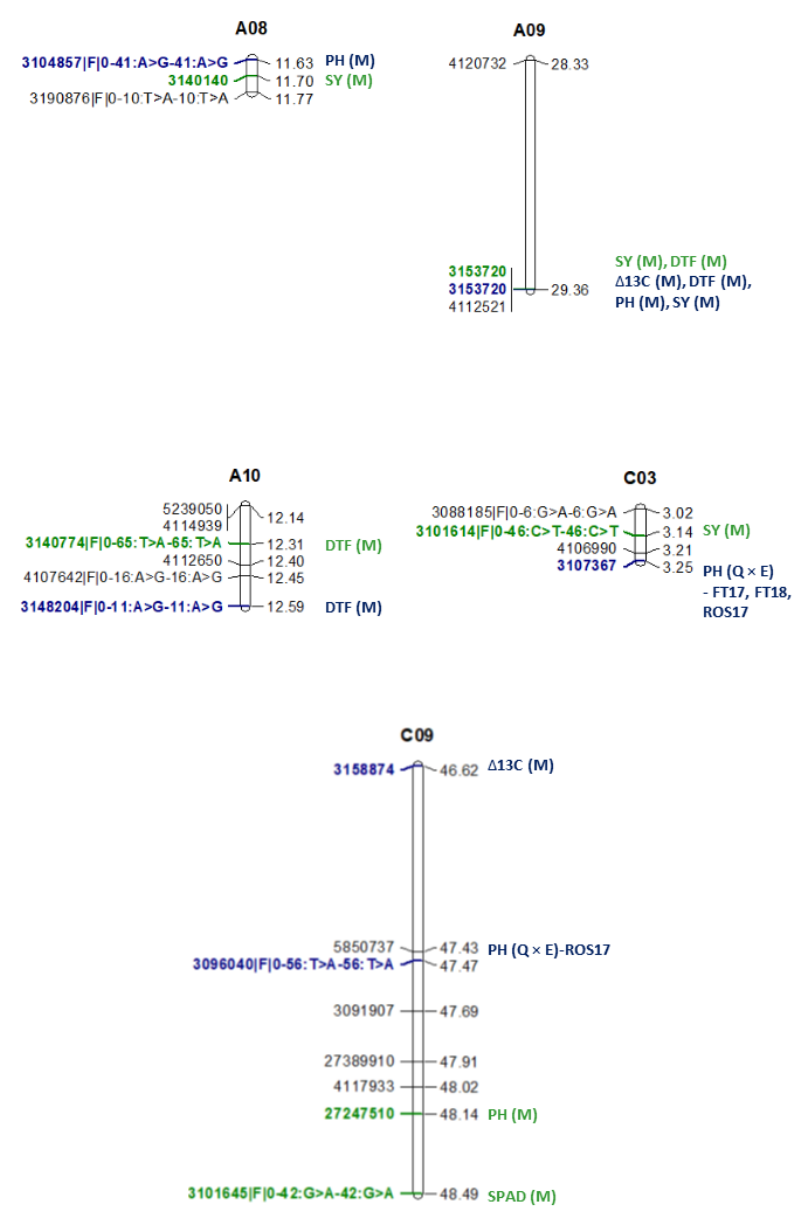
Figure 5. Graphical representations of QTL associated with multiple traits in a doubled haploid population of B. napus . Map distances (Kosambi) are shown in CentiMorgans (on right). Marker names are shown on the left-hand side. SY: Seed yield, PH: Plant height; SPAD: Chlorophyll content; DTF: Days to flower; ∆ 13 C: carbon isotope discrimination. QTL for main effects are depicted by M, and QTL by Environment interactions are depicted by ‘Q × E’. Field trial 2018: FT 18, Field trial 2019: FT19; pot trial in a rainout shelter 2017: ROS17.